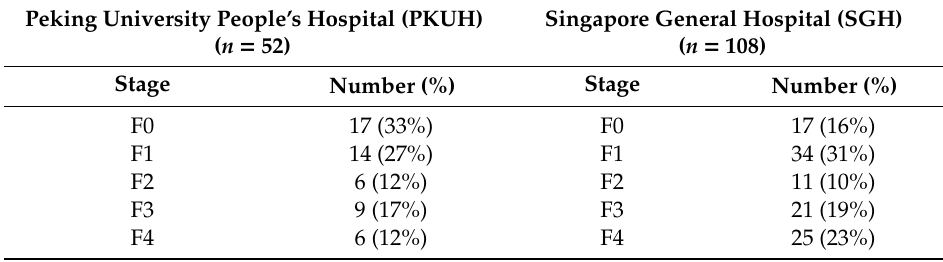
Table 1. Distribution of samples according to non-alcoholic steatohepatitis (NASH) fibrosis stages before the consensus